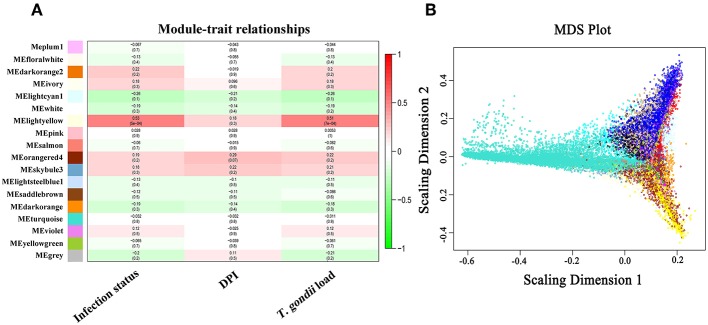
(A) Module and traits relationships. The color-coded legend shows the correlation degree, with positive and negative numbers indicating positive and negative relationship, respectively (B). The classical multidimensional scaling plot of all transcripts.